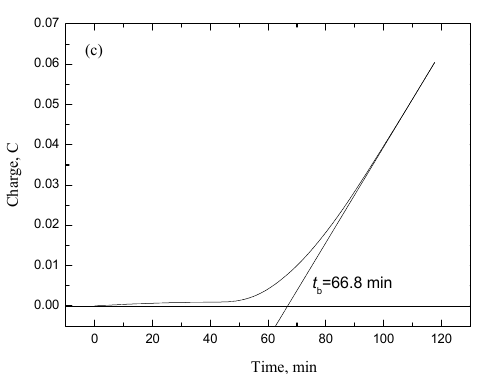
Figure 4. Hydrogen permeation curves of hot rolled enamel steel coiled at different temperatures: ( a ) 600 °C; ( b ) 650 °C; ( c ) 700 °C.